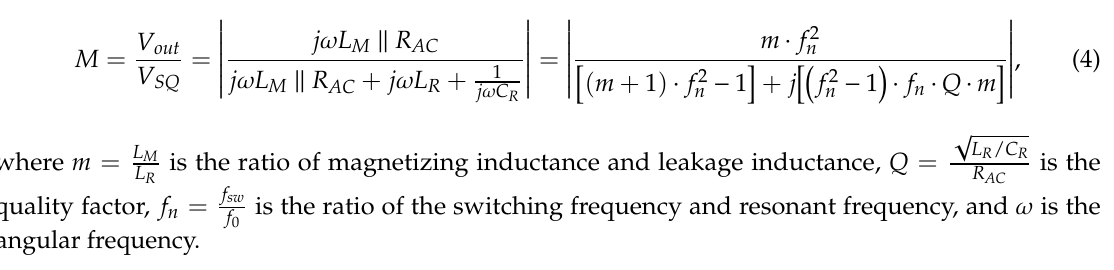
Figure 5. Simplified converter circuit of the LLC half ‐ bridge converter.